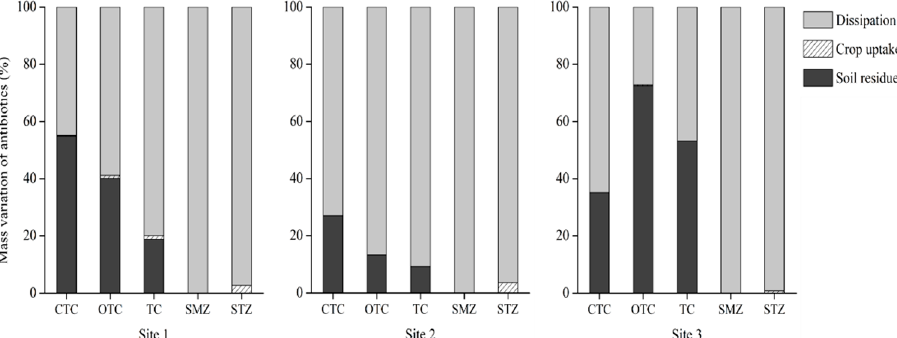
Figure 1. Mass balance of tetracycline and sulfonamide antibiotics in soil. Dissipation percentages of the STZ and SMZ in the three sampling sites were 83.6– 97.0% and 100%, respectively, whereas CTC, OTC, and TC were 43.1–72.9%, 25.9–86.6%,